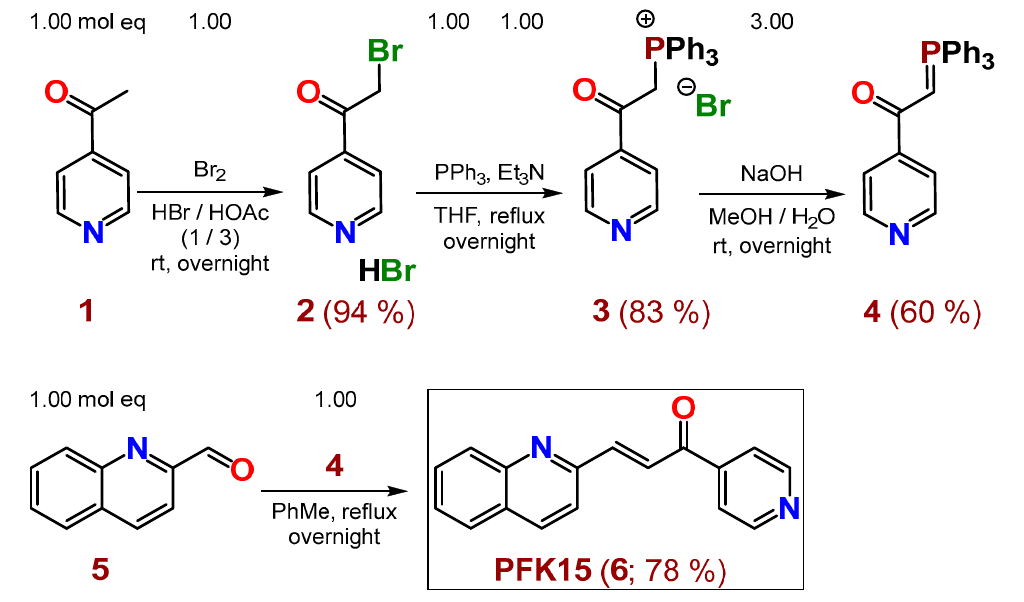
Scheme 1. Synthesis of inhibitor PFK15 ( 6 ), starting from commercially available 1-(pyridin-4- yl)ethan-1-one ( 1 ) and 2-quinolinecarboxaldehyde ( 5